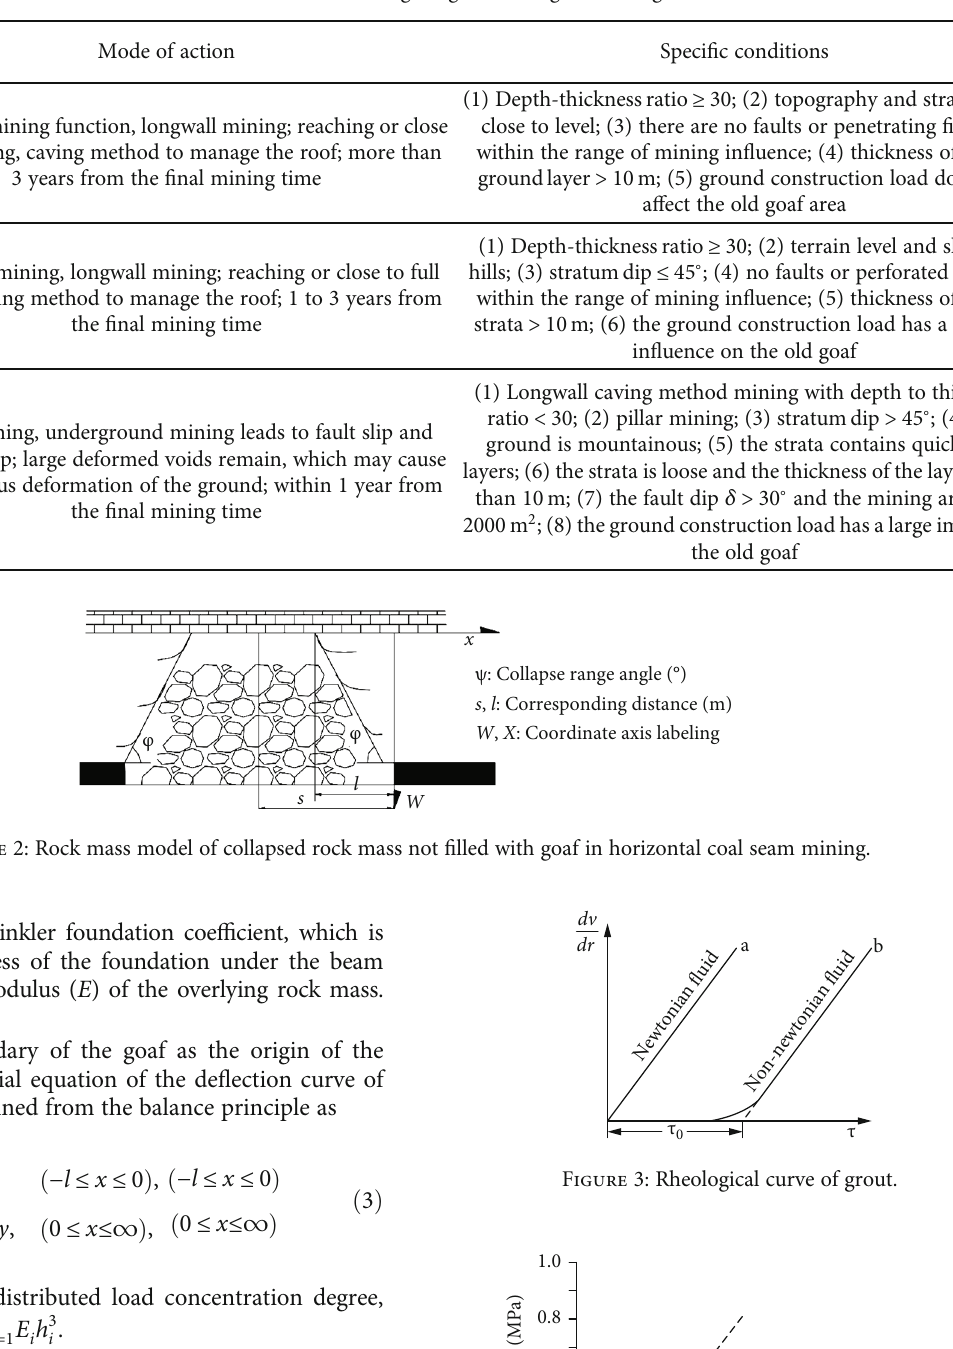
Table 1: Classi fi cation table of geological mining model of goaf.